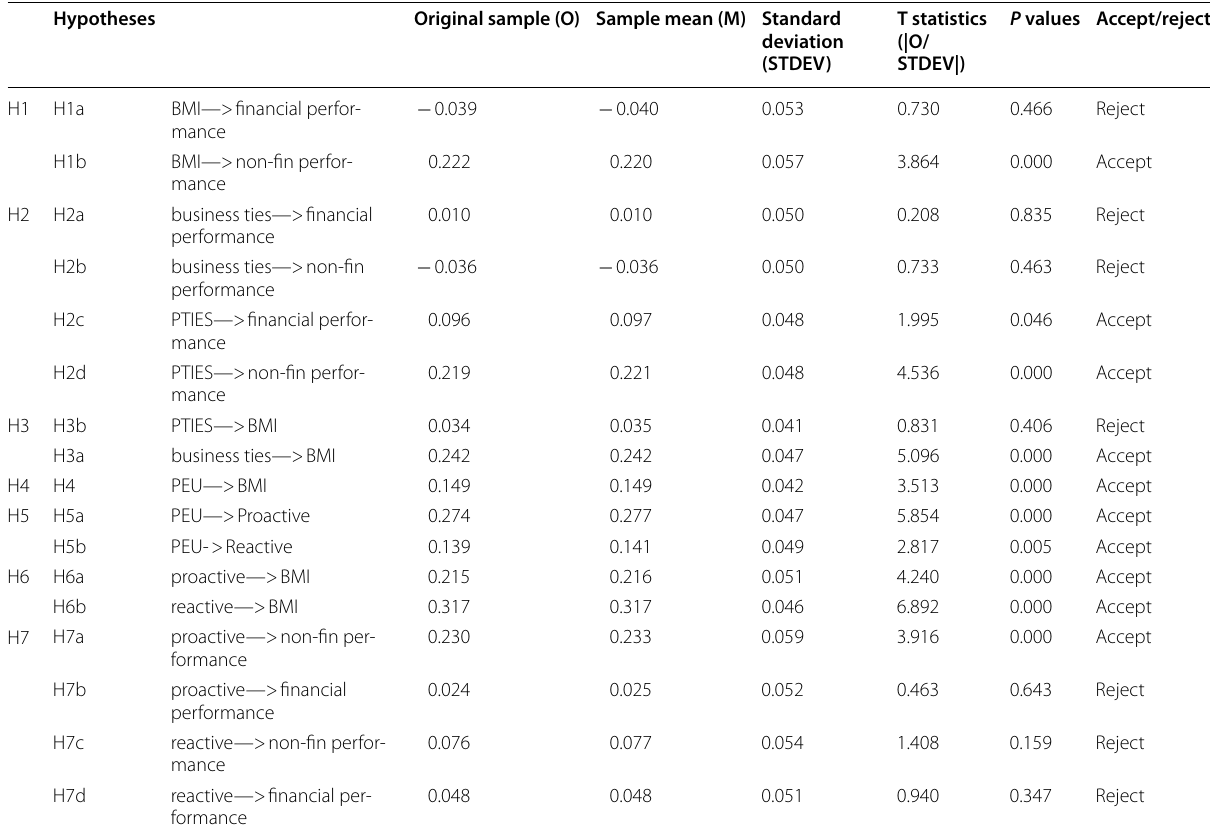
Table 3 Direct relationships (All hypotheses except H9, H8)